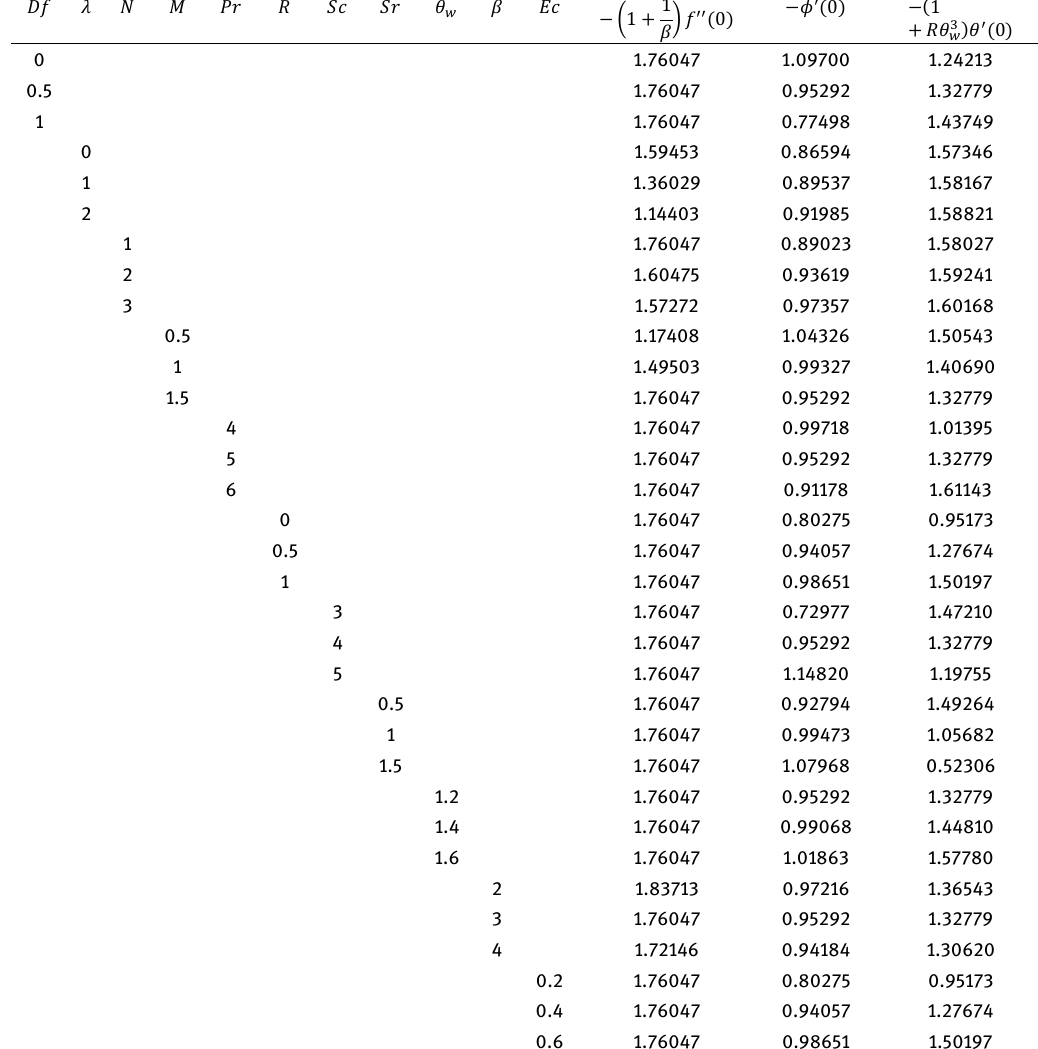
′′ (︁ )︁ 1 + 1 (0) , ϕ ′ (0) and f β